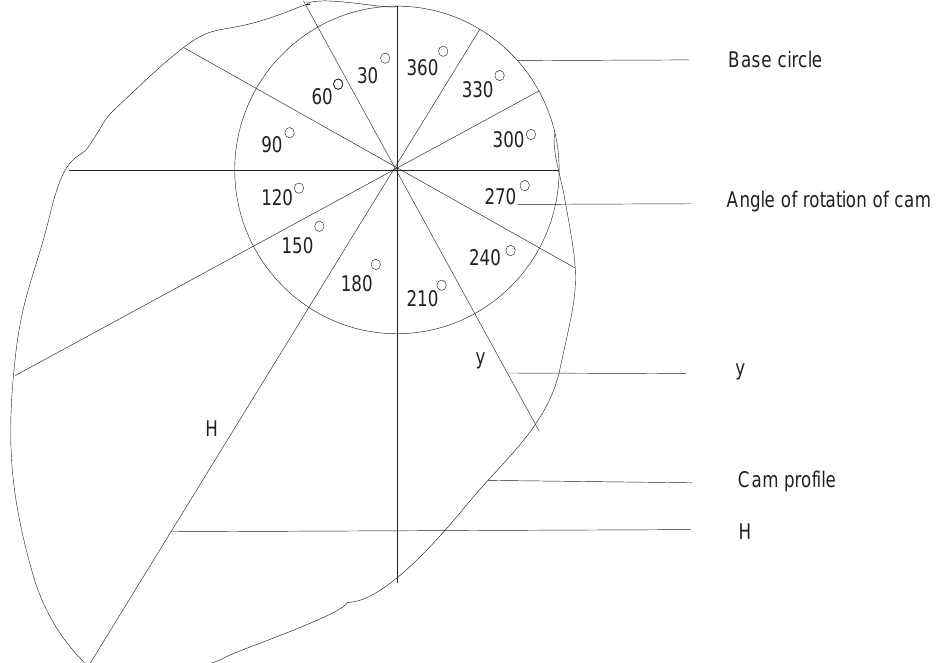
Figure 1. The layout of the developed cam shape using the values generated from the cam formula